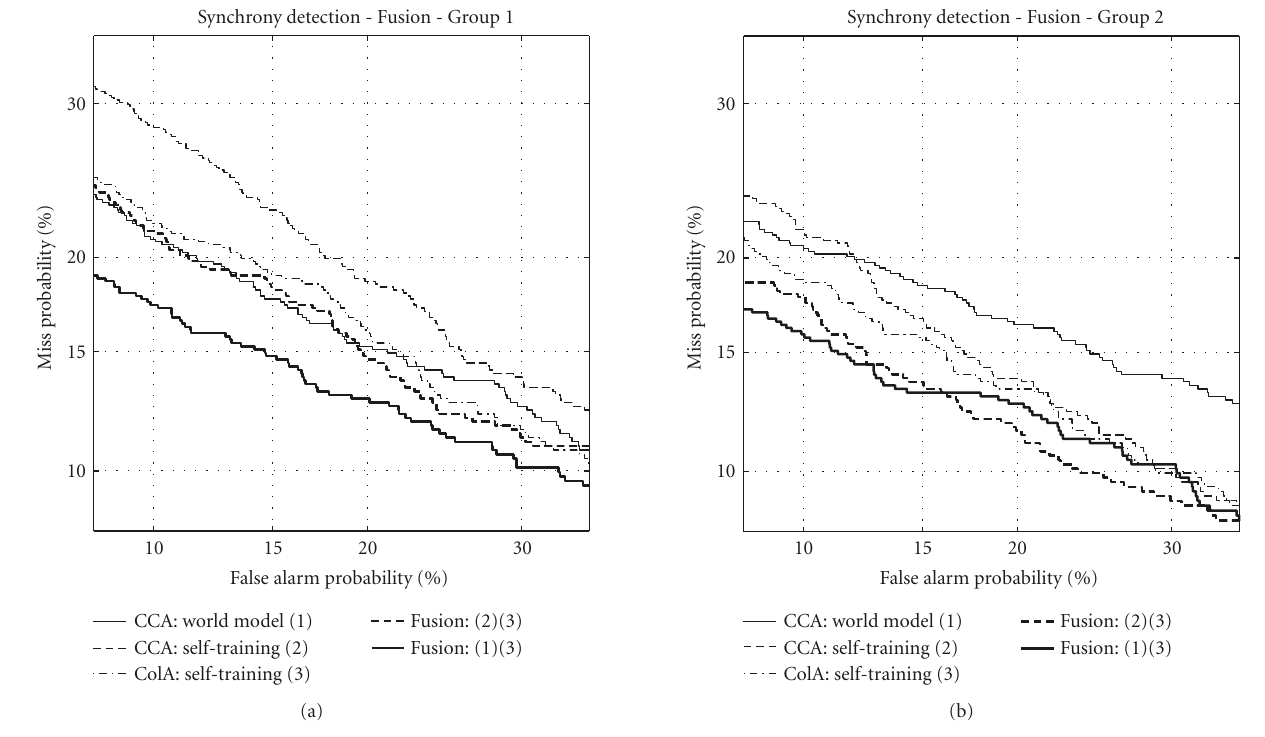
Figure 3: Fusion of CoIA and